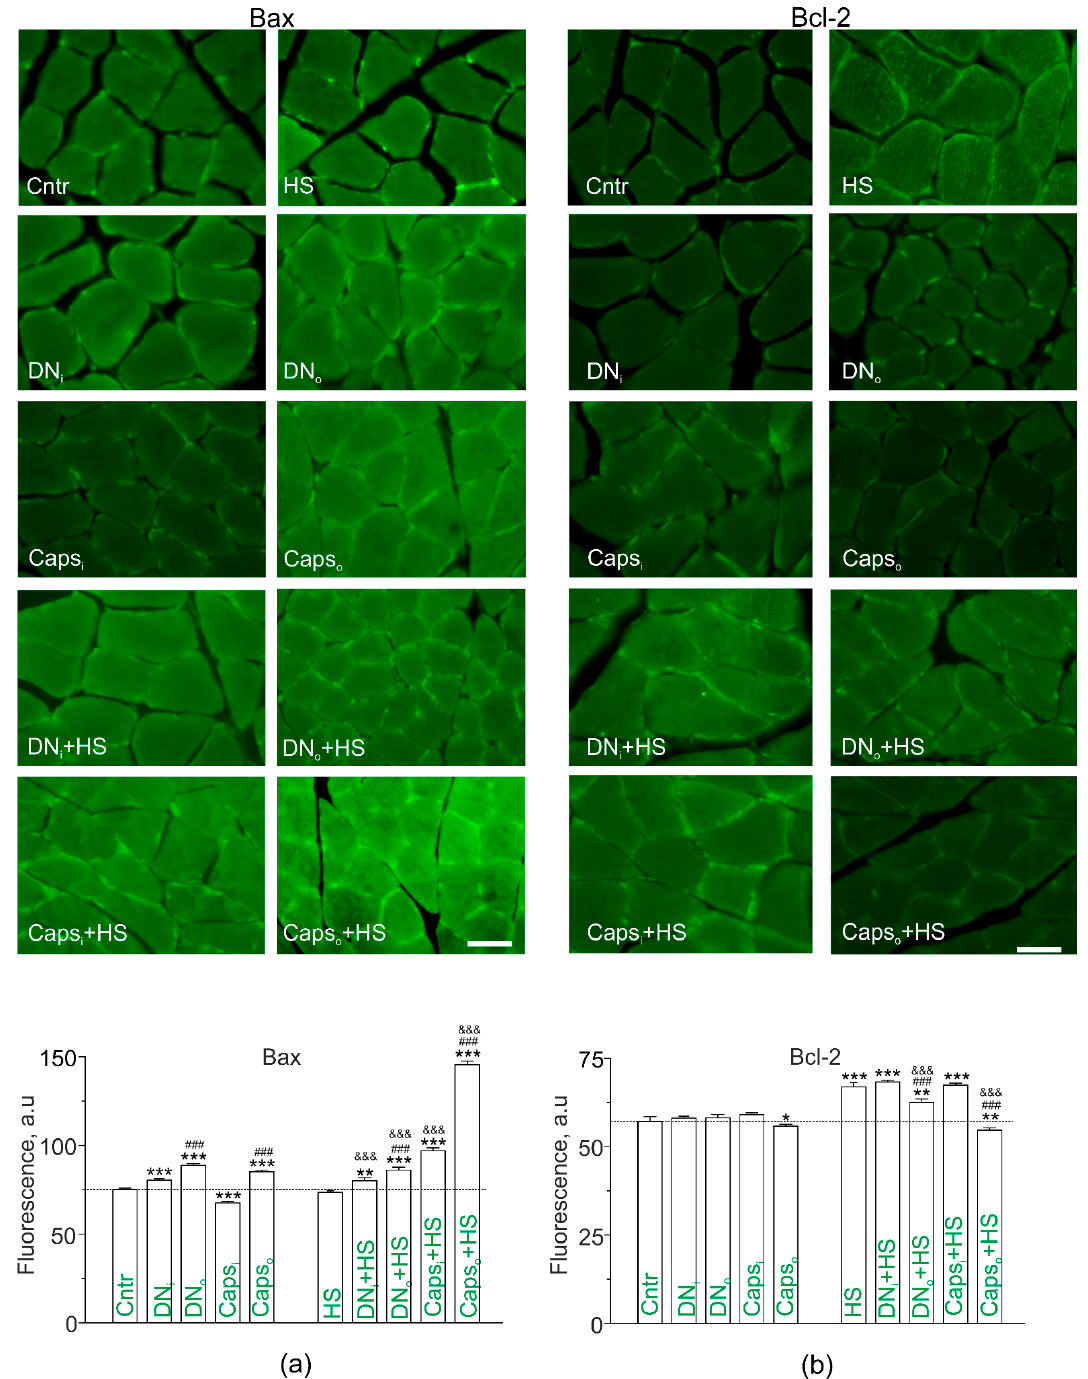
Figure 7. Bax and Bcl-2 immunoexpression. Left ( a ) Bax immune fluorescence is enhanced on longitudinal sections of both denervated (DN o ) and nondenervated (DN i ) soleus muscle, but oppositely changed in the muscles from the limbs of rats with unilateral Caps application on the sciatic nerve (Caps i —intact and Caps o —operated leg). Bax in soleus muscles taken from operated or nonoperated legs of hindlimb suspended rats. Right ( b ) Bcl-2 immune fluorescence is not significantly changed in denervated (DN o ) and nondenervated (DN i ) soleus muscle, and slightly decreases in Caps-treated (Caps o ) muscle. Bcl-2 is upregulated in 12-h disused soleus muscles; Bcl-2 staining is lower in the limbs of suspended with surgically denervated or Caps-treated sciatic nerve animals. Left and right, scale bars—10 µ m. ( a,b ) Quantification of fluorescence (mean ± SEM); * p < 0.05, ** p < 0.01, *** p < 0.001—differences compared to control; &&& p < 0.001—differences compared to HS; ### p < 0.001—differences between intact and operated limb. p was evaluated by a two-way ANOVA followed by Bonferroni post hoc test. N = 4 for each